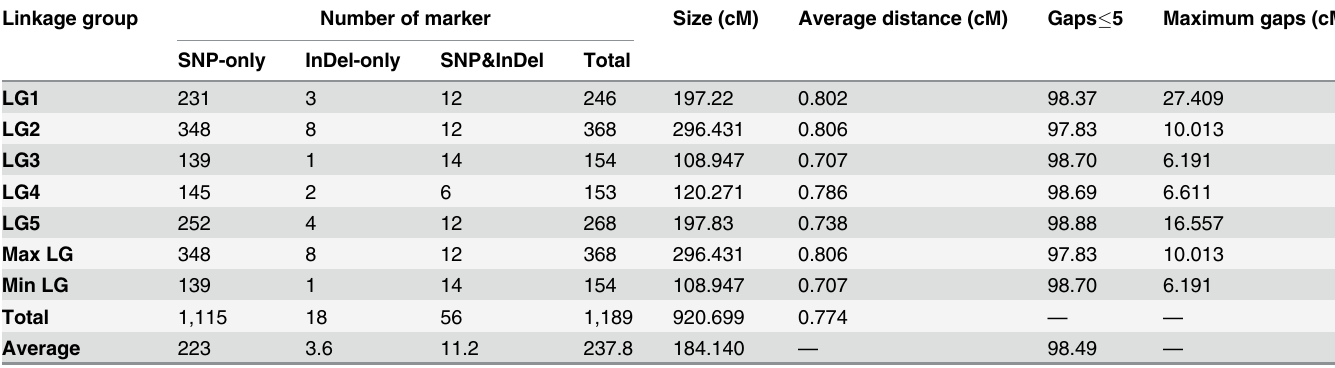
Table 4. Summary of integrated linkage map of tree peony. Linkage